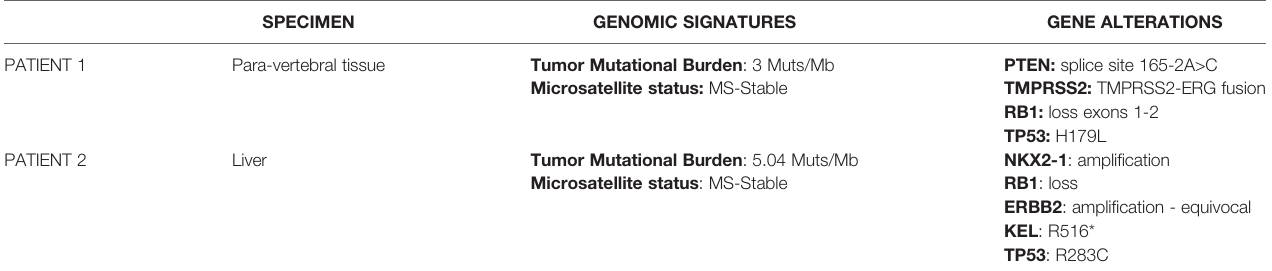
TABLE 1 | Patient 1 and patient 2 genomic signatures and gene alterations detected with next generation sequencing assay FoundationOne